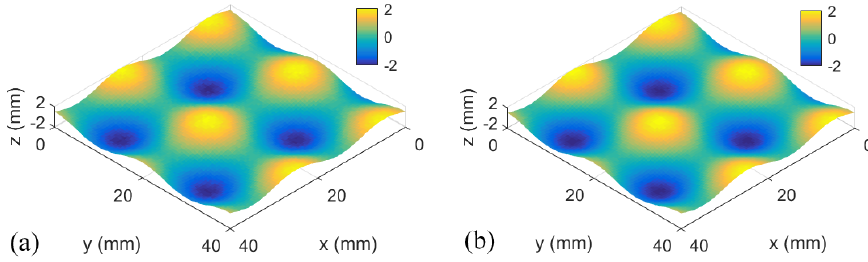
Figure 6. Simulated measurement results of the designed sinusoidal surface: ( a ) with 30 μ m measurement noise; and ( b ) with 20 μ m measurement noise.